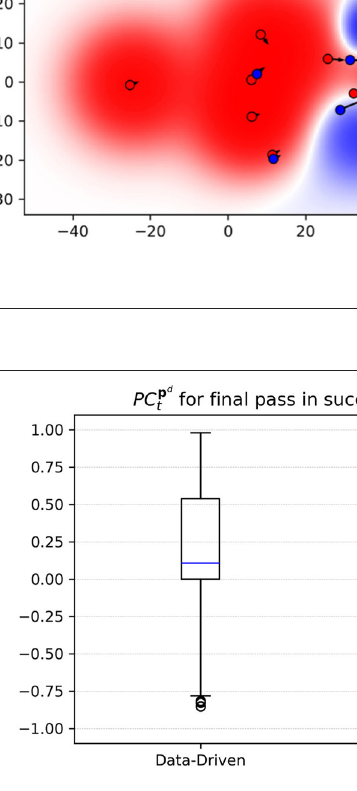
FIGURE 6 | PC for final passes before a shot was